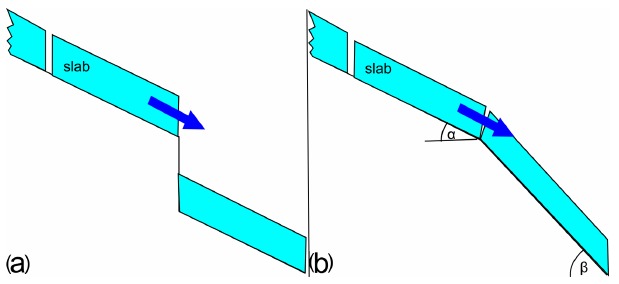
Figure 6. Cases where no stauchwall forms: either there is a terrain drop (a) or the area below the release is steeper than the release area (b) .